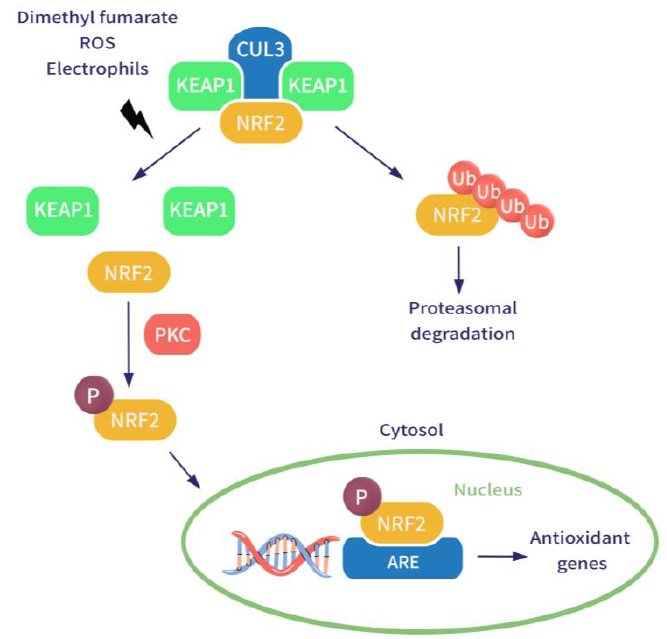
Figure 2. Effect of dimethyl fumarate on Nrf2 pathway. Abbreviations: NRF2, nuclear factor (erythroid-derived 2)-related factor; ARE, antioxidant response element; CUL3, Cullin3; KEAP1, Kelch-like ECH-associated protein; PKC, protein kinase C; Ub, ubiquitin; ROS, reactive oxygen spe- cies.